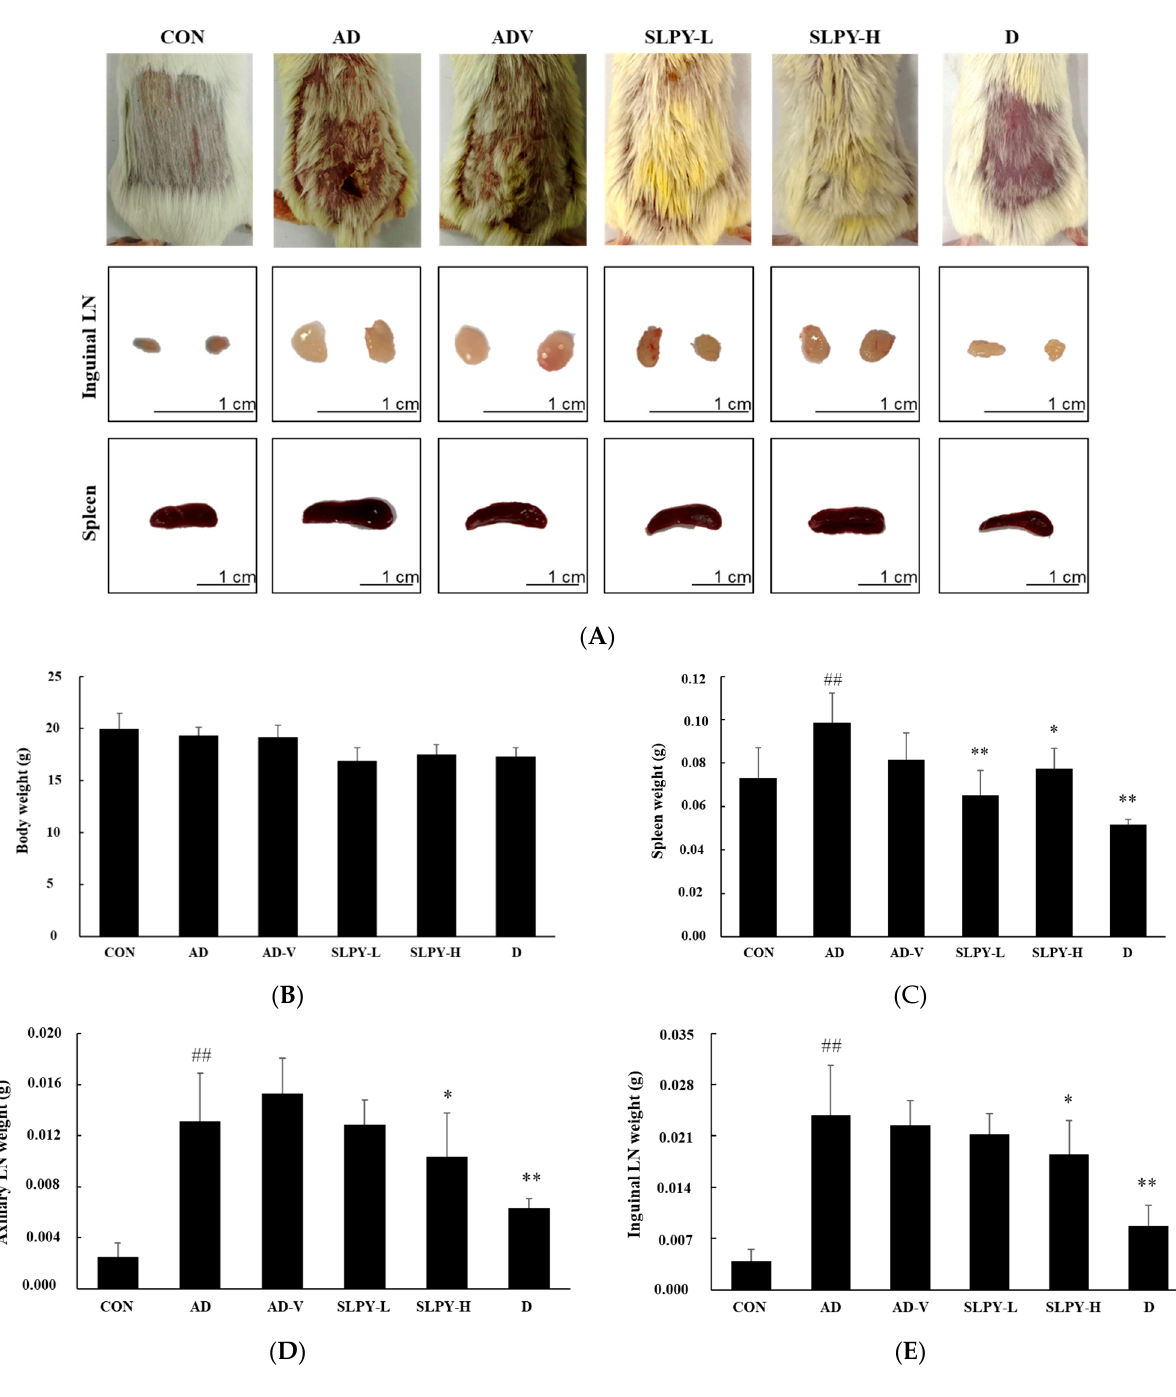
Figure 4. Effect of SLPY topical application on AD-like skin injuries in DNCB-induced BALB/c mice. ( A ) Clinical characteristics, size of inguinal lymph node, and size of spleen of DNCB-treated AD mice. ( B ) Body weight, ( C ) spleen weight, ( D ) axillary lymph node weight, and ( E ) inguinal lymph node weight of control, AD, ADV, SLPY, and Dermatop-treated groups. The values are expressed as mean ± SD of at least three replicates. ## p < 0.01 vs. the corresponding control group and ** p < 0.01, * p < 0.05 vs. the corresponding treatments groups. CON: non-treatment group; AD: 2,4-dinitrochlorobenzene (DNCB)-induced group; ADV: combined treatment of 1% DNCB and vehicle; SLPY-L: combined treatment of 1% DNCB and 50 mg/Kg SLPY; SLPY-H: combined treatment of 1% DNCB and 100 mg/Kg SLPY; D: combined treatment of 1% DNCB and Dermatop (0.25% ( w/w ).